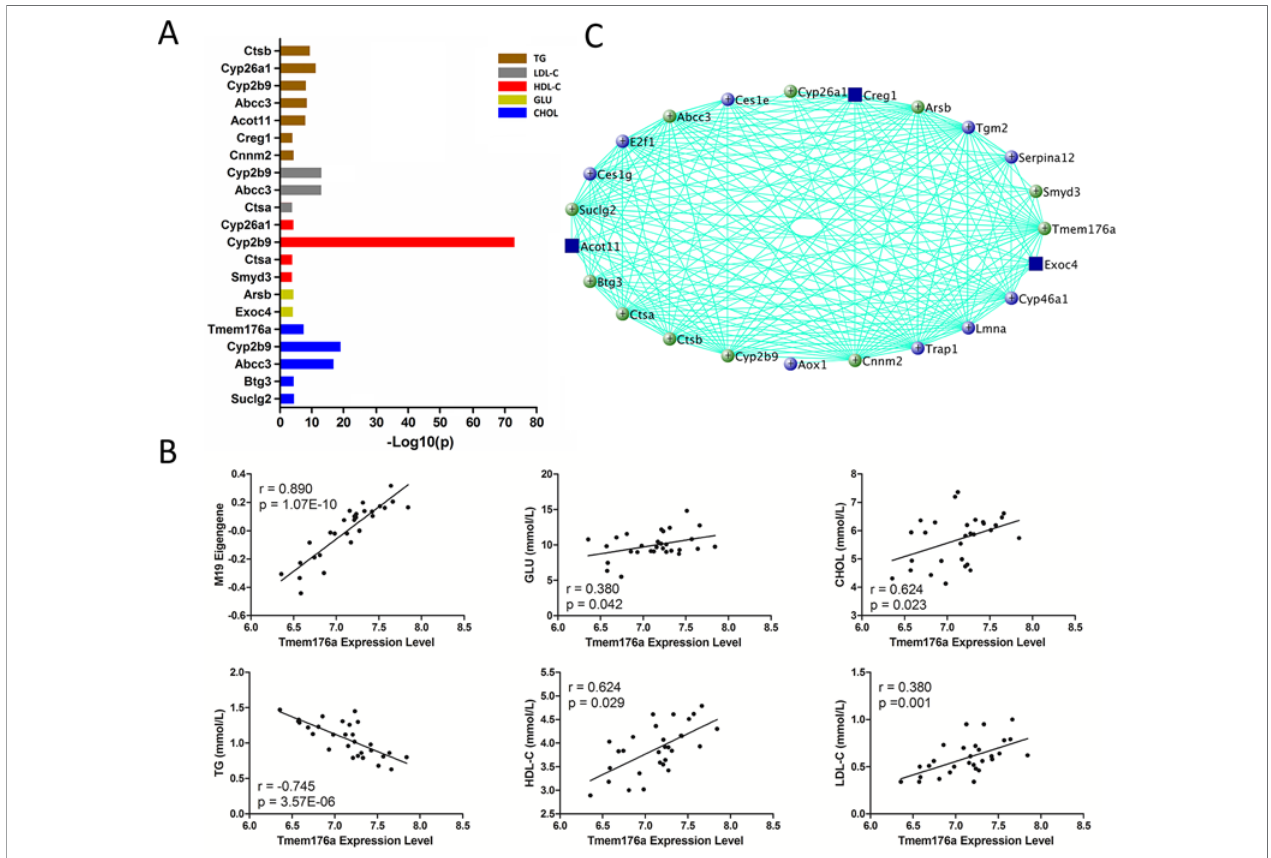
FIGURE 4 | Gene prioritization for module M19. (A) Human GWAS overlapping genes for module M19. Genes with GWAS p value <1 × 10 − 4 for blood lipid and fasting glucose levels were retrieved from GRASP and GWAS Catalog. (B) Correlations between module M19 hub gene Tmem176a and MEs and traits. (C) Gene subnetwork for module M19. Green circles represent genes overlapping with human GWAS; blue circles represent genes functionally validated in mouse models; both functionally validated and GWAS overlapping genes are marked with blue rectangles.